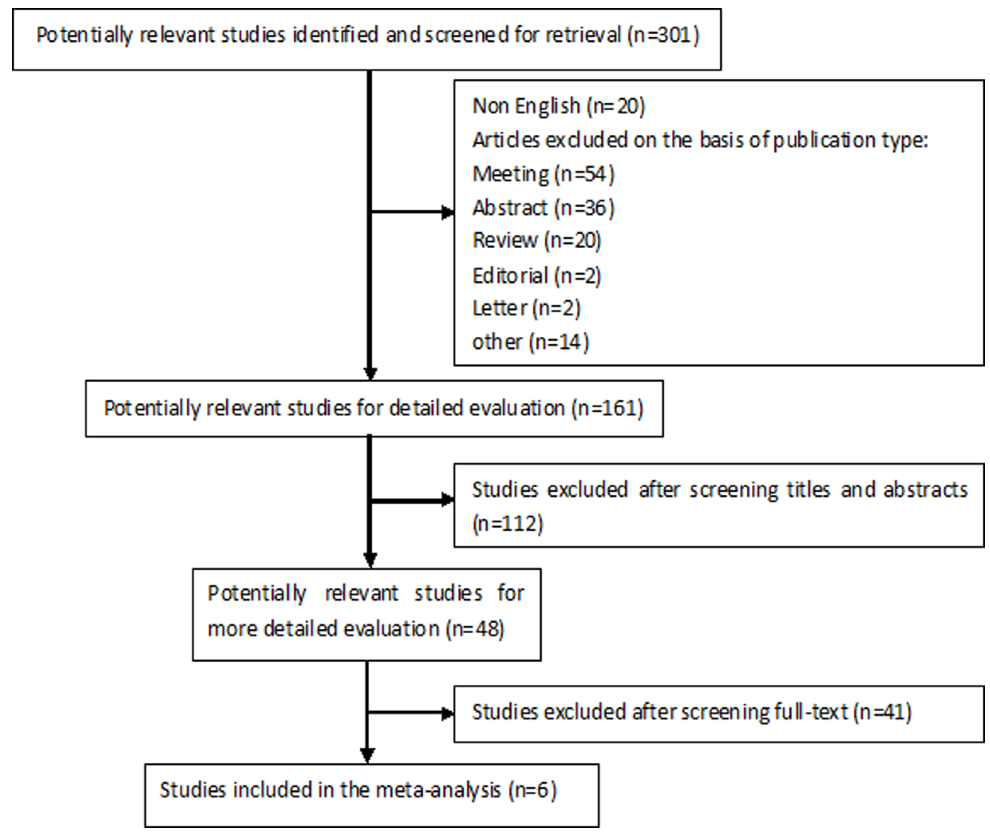
Figure 1. Flow chart showing the process for selecting eligible studies in this meta-analysis.